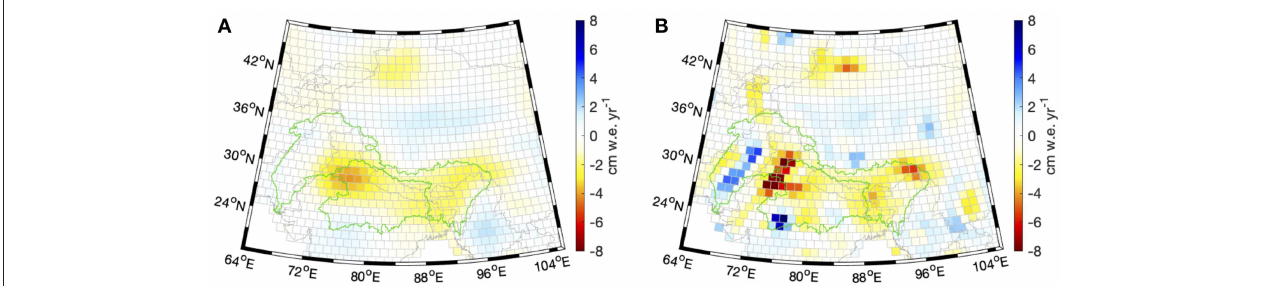
FIGURE 2 | GRACE mass trends in terms of centimeter water equivalent per year (cm w.e. yr − 1 ), as determined from (A) the GSFC monthly mascon solution, and (B) the GSFC L1B regression solution. Trends are computed for January 2003–July